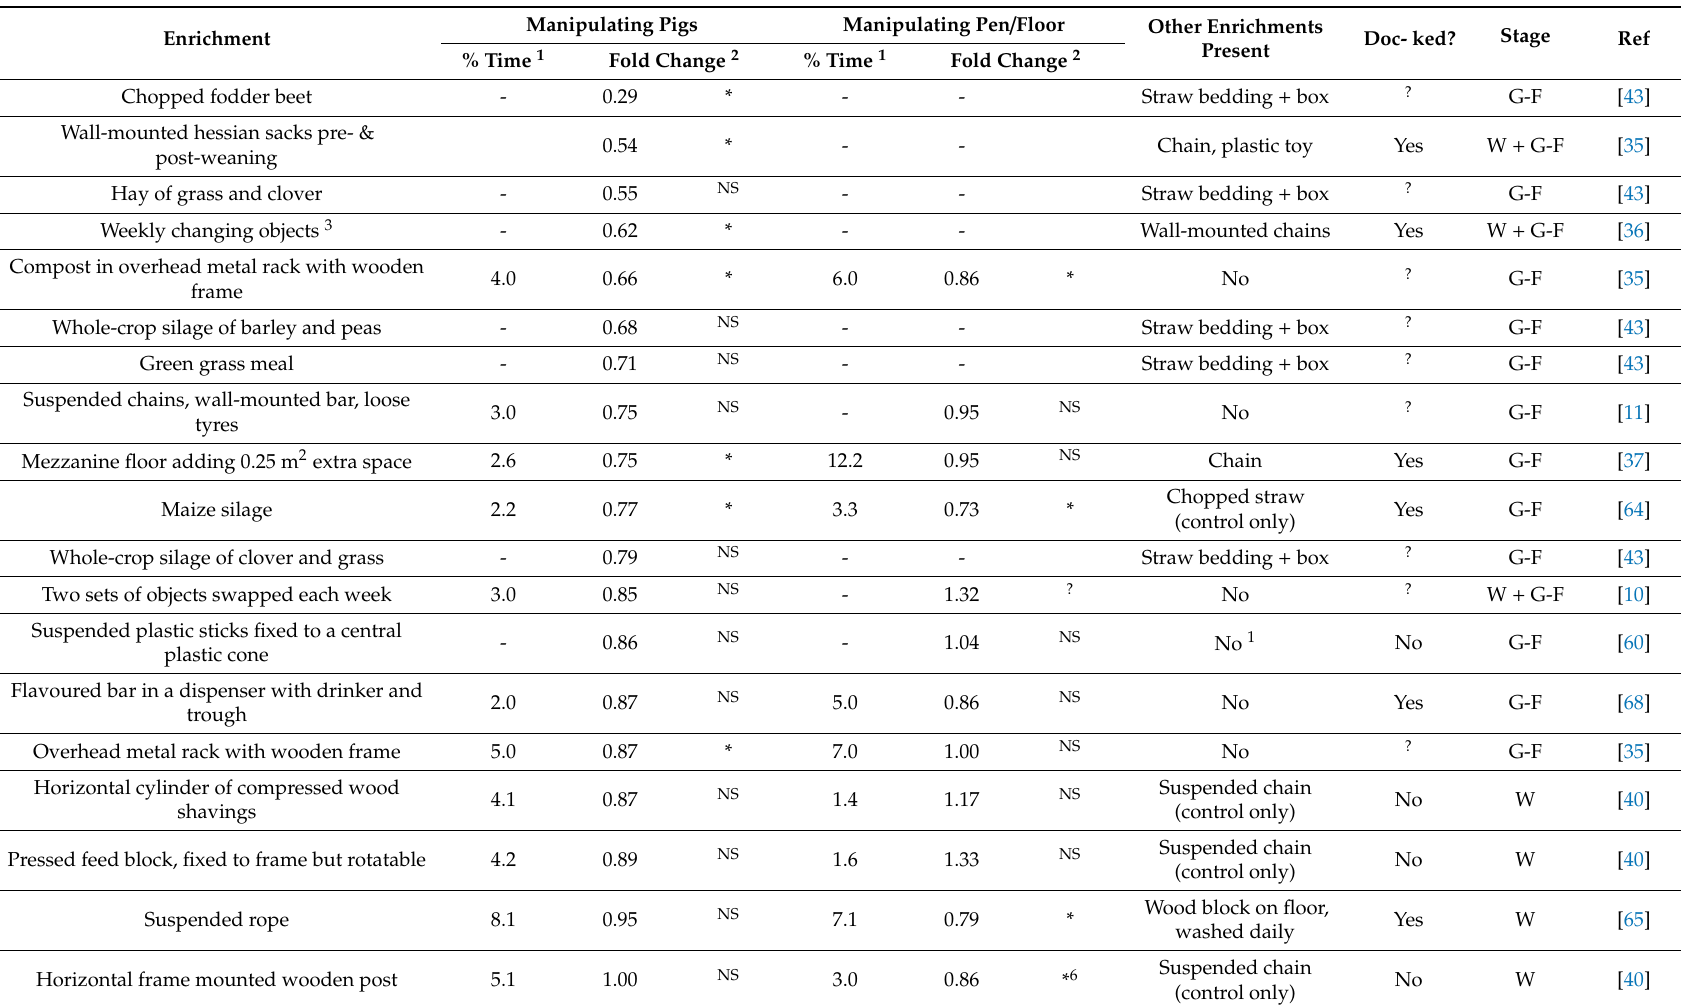
Table 2. E ff ects of enrichment on manipulation of pen mates and pen